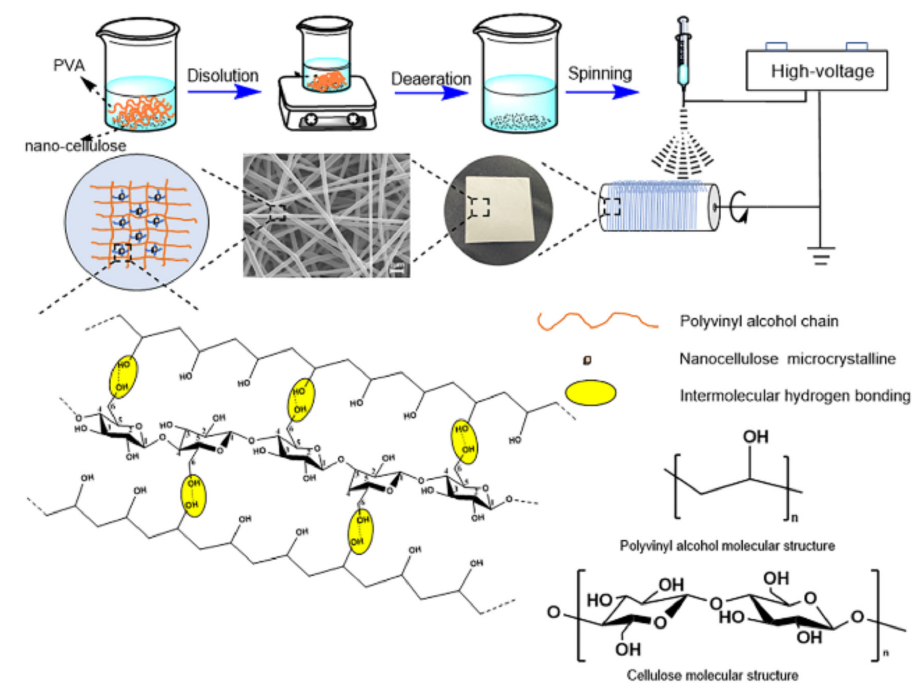
Figure 13. Preparation scheme of PVA/NC nanofiber